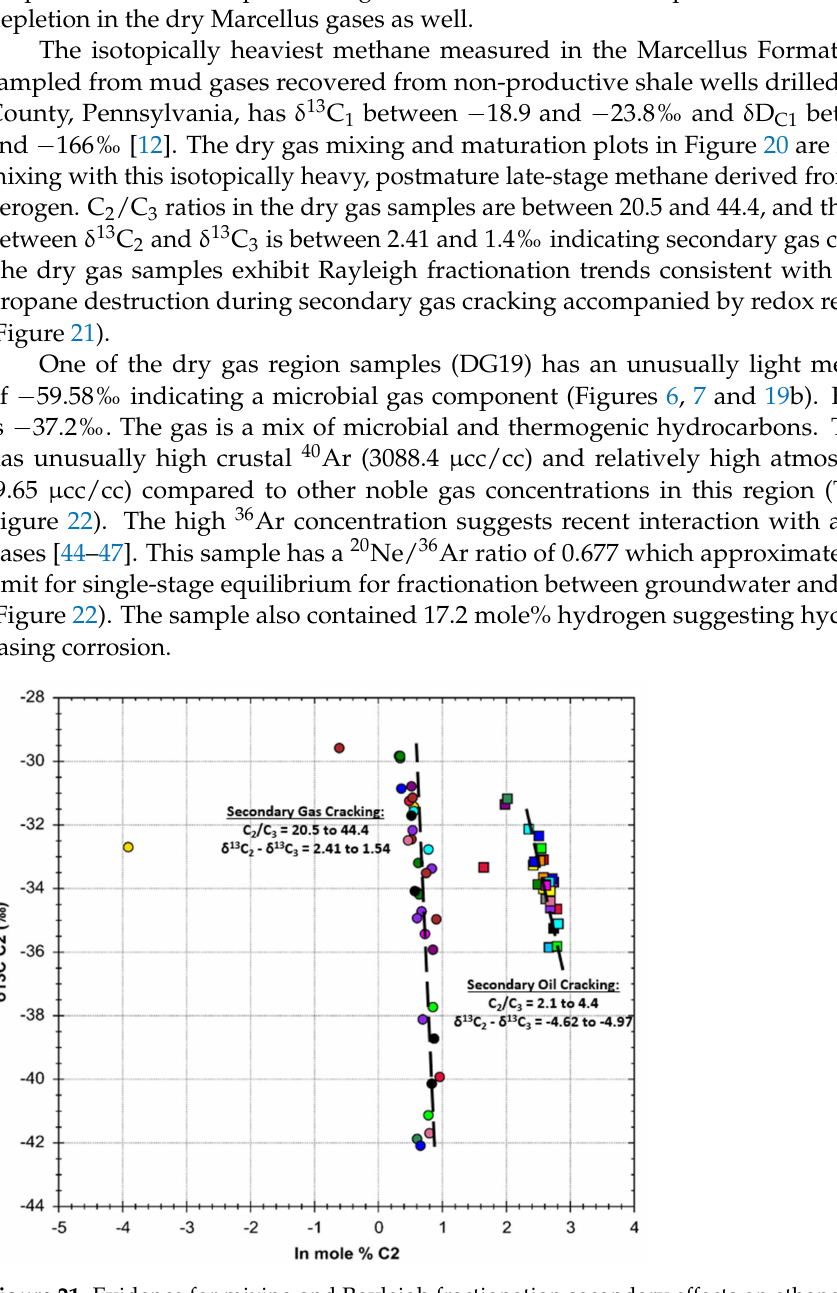
Figure 21. Evidence for mixing and Rayleigh fractionation secondary effects on ethane in Marcellus Formation gases. The isotopic composition of ethane in both the wet and dry gases is a linear function of the natural logarithm of the concentration indicating Rayleigh fractionation [71,72]. Wet gases (squares) exhibit chemical and isotopic compositions consistent with oil cracking [70]. Dry gases (circles) exhibit compositions consistent with secondary gas cracking